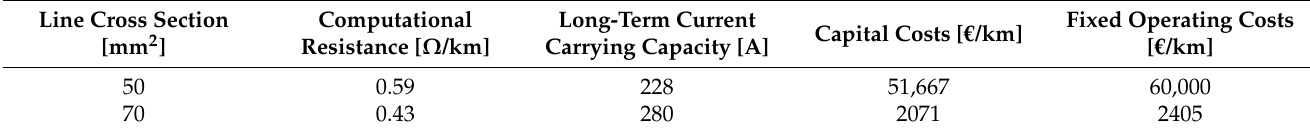
Table 3. Parameters of new